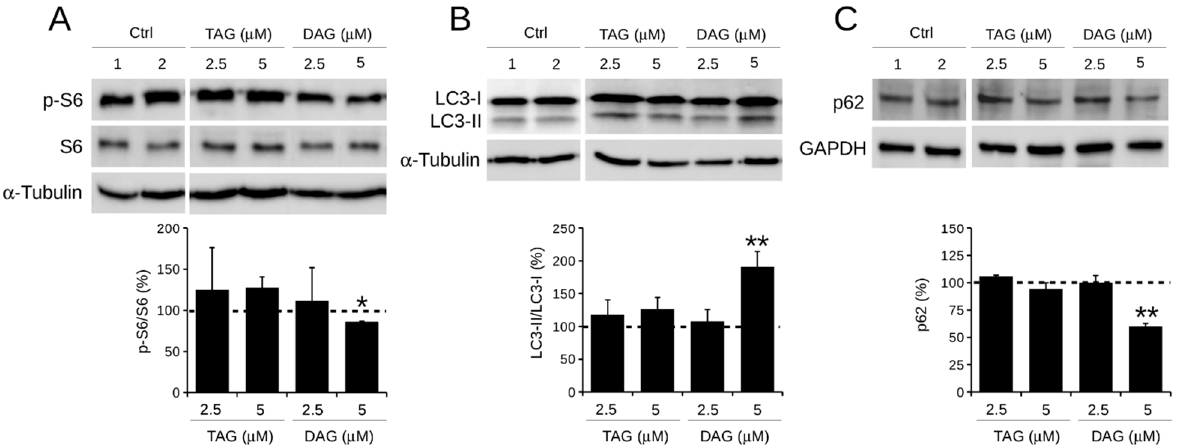
Figure 4. Effect of TAG and DAG on autophagic markers expression in SH-SY5Y cells. Cells were treated with 2.5 or 5 μ M of TAG and DAG for 24 h. Control cells (Ctrl) were treated with two doses of DMSO vehicle, i.e., (1) 0.005% DMSO and (2) 0.01% DMSO. Expression levels of protein autophagic markers, i.e., ( A ) p-S6/S6, ( B ) LC3-II/LC3-I, and ( C ) p-62, were detected by Western blot assay. Quantification of signals was determined by densitometry analysis. Error bars represent standard errors. * p < 0.05; ** p < 0.01 vs. Ctrl (represented by dashed line); Kruskal–Wallis test. Overall, these results suggest that only 5 µ M DAG activates an autophagic process observable at 24 h of